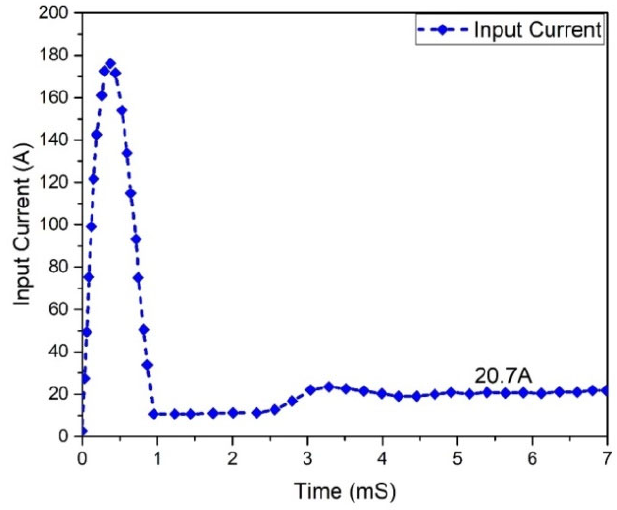
Figure 8. Input current analysis of Flyback boost converter.